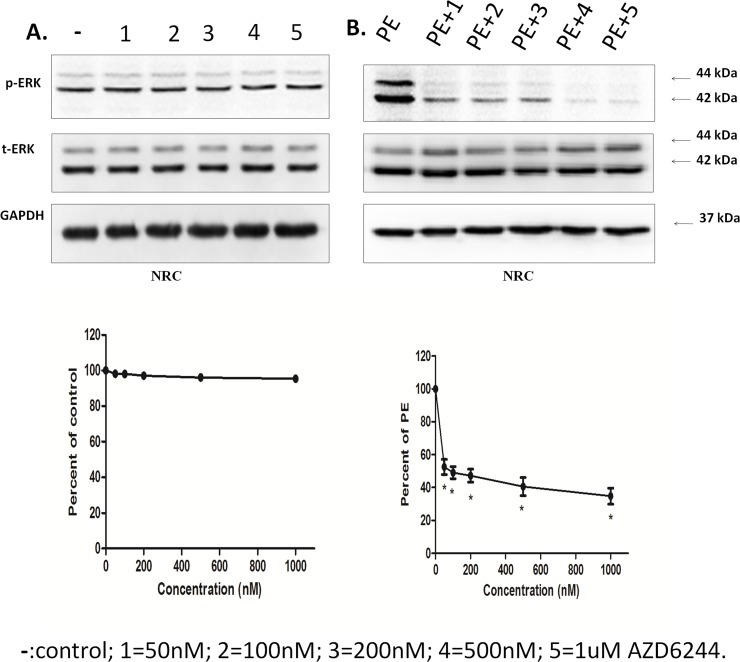
The ERK inhibition effect with AZD6244 was mild in normal cardiomyocytes, but it was more significant in hypertrophic hearts.(A).Upper Panel: Representative immunoblots using antibodies against phosphorylated ERK1/2 (pERK1/2) and total ERK1/2 (ERK1/2) to probe proteins extracted from NRCs lysates treated with 50 nM, 100 nM, 200 nM, 500 nM, and 1μM AZD or without AZD. Lower Panel: the percent of pERK/tERK normalized to control, n = 3. (B).Upper Panel: representative immunoblots using antibodies against phosphorylated ERK1/2 (pERK1/2) and total ERK1/2 (ERK1/2) to probe proteins extracted from NRCs lysates treated with PE and AZD or without AZD. Lower Panel: the percent of pERK/tERK normalized with PE. * Significantly different from PE(P<0.001, n = 3).